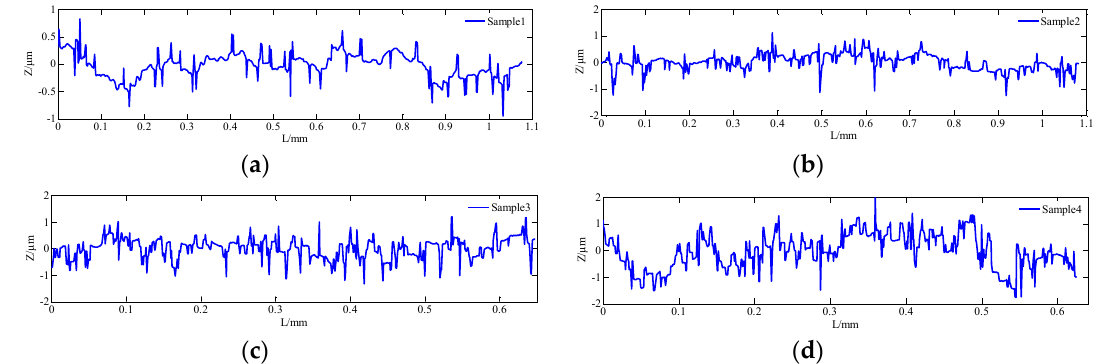
Figure 5. Actual surface profile curves of different processing methods ( a ) The upper surface of specimen 1 machined by grinding; ( b ) The lower surface of specimen 2 machined by grinding; ( c ) The upper surface of specimen 3 machined by milling and ( d ) The lower surface of specimen 4 machined by milling. ( a ) the upper surface of specimen 1 machined by grinding.